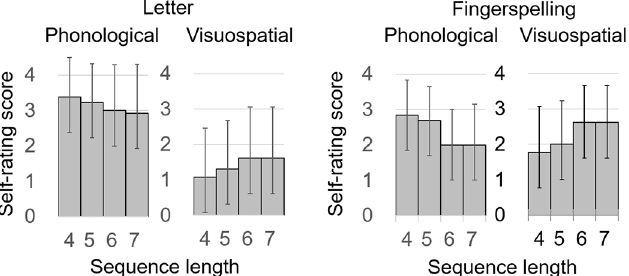
Fig 2. Self-rating scores of cognitive strategies used during the maintenance stage. ‘Phonological’ represents the degreeof subjective relianceon phonologicalimageryof spoken sounds, whereas ‘Visuospatial’ on visuospatialimageryof letter- or finger-shapes (0 = not at all, 4 = all the time). After all imagingsessions were completed,participants were requested to recall these covert strategies that they had used duringmaintenance. Irrespective of the stimulus type (i.e. letters or fingers), participantsrelied on the phonological memory more greatly than on the visuospatialmemory. However, this subjectiverelianceon phonological memory did not significantly differ betweenletters and fingerspelling (see